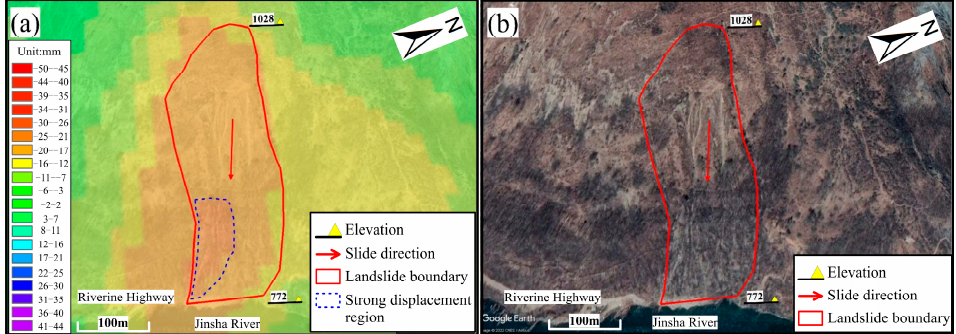
Figure 8. ( a ) The MLP neural network atmosphere corrects the displacement results; ( b ) remote interpretation of displacement.